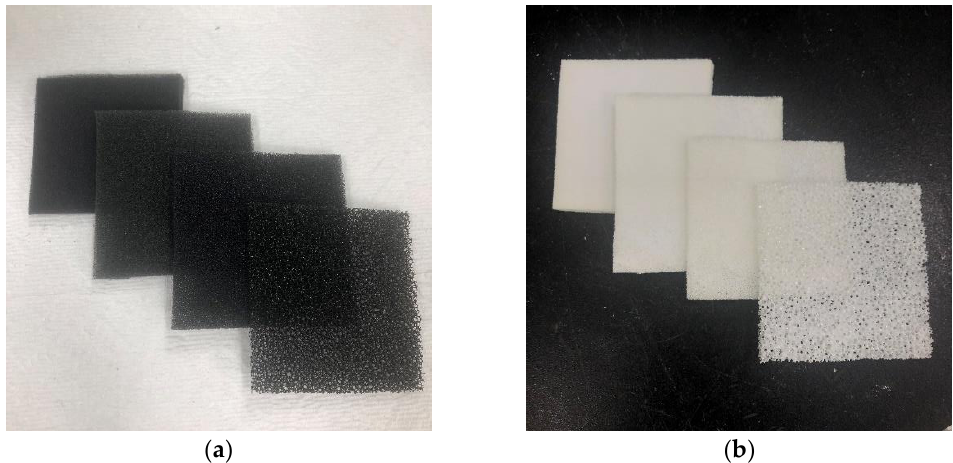
Figure 1. Optical images of ( a ) commercial polyurethane foam samples with pore densities of 80, 60, 45, and 25 PPI (left to right, respectively), which were used as sacrificial polymer templates as part of the replica method, and ( b ) reticulated porous zirconia specimens with pore densities of 80, 60, 45, and 25 PPI (left to right, respectively) sintered at 1480 °C.